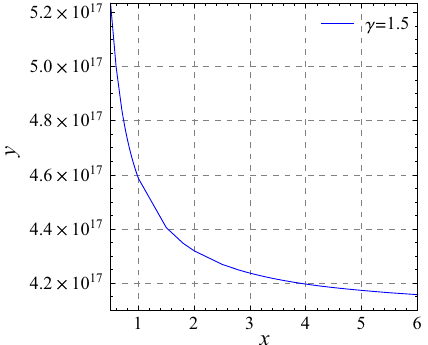
Fig. 5 The compression factor ( y ) for a fluid (cid:12) = 1 . 5 accreting onto the black hole with M = 40 radius